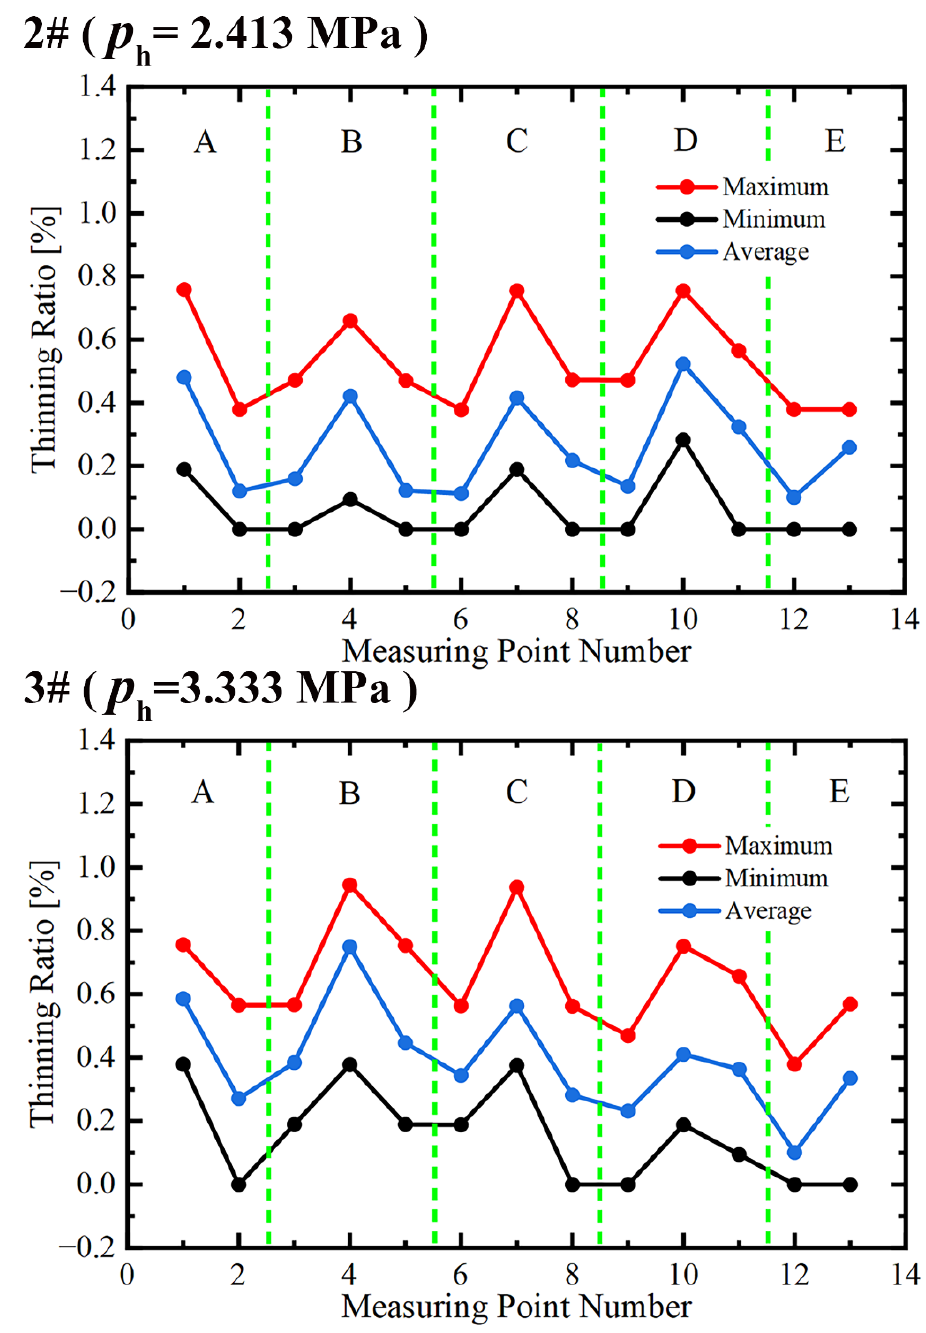
Figure 15. Thicknesses thinning ratio after hydroforming of two preformed toroids.